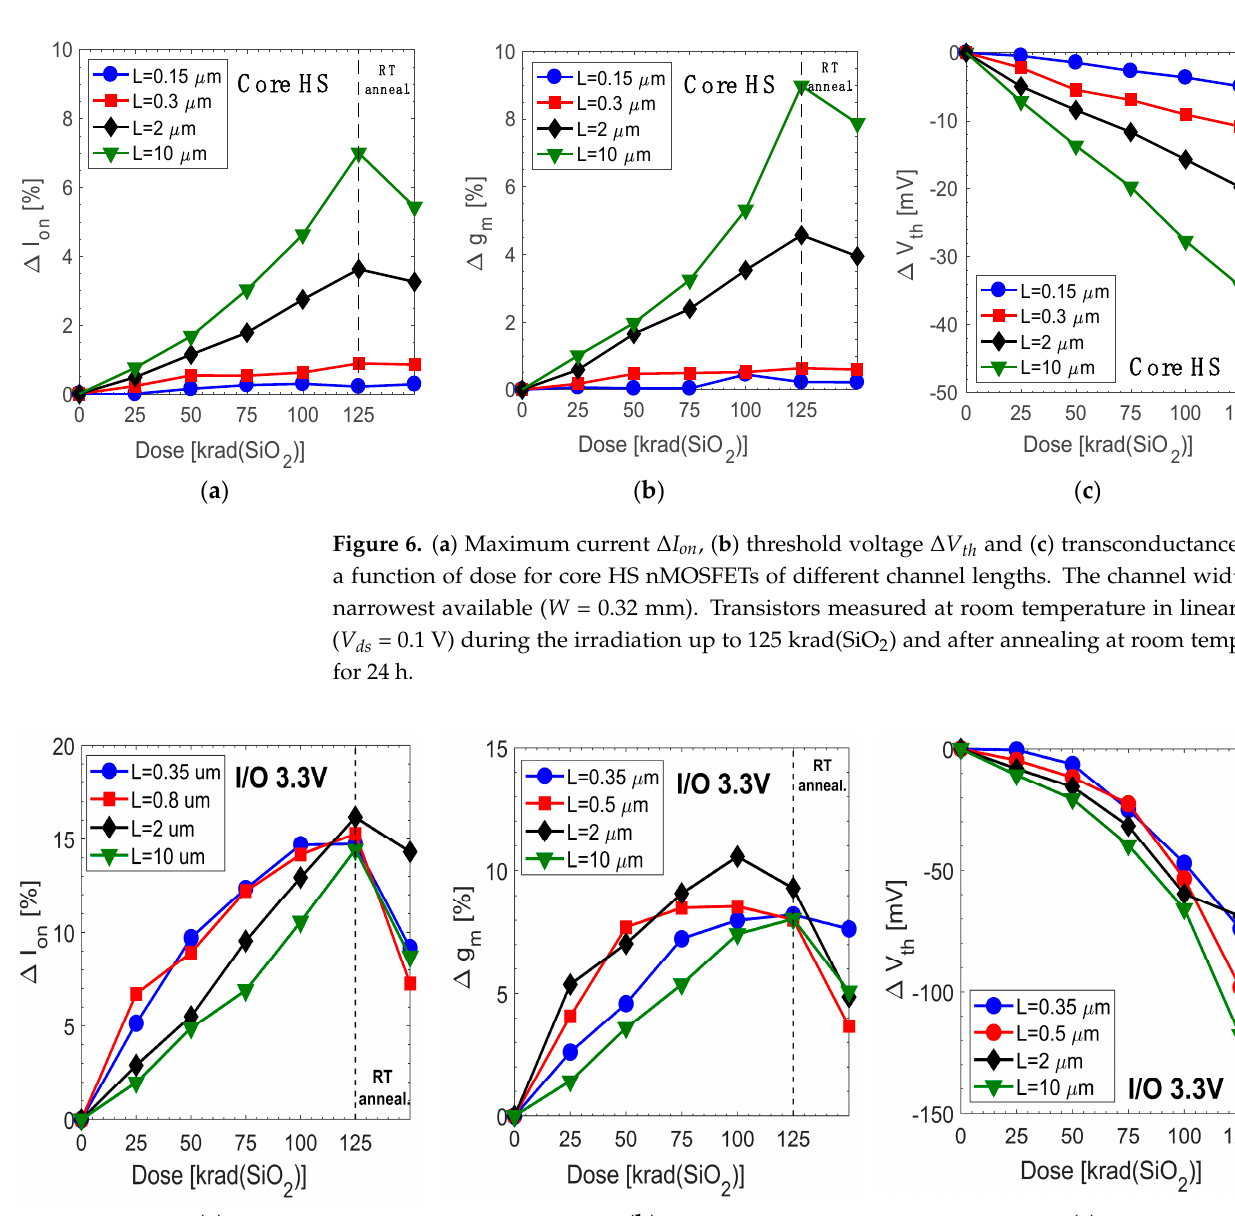
9 of 14 Figure 5. Δ V th is plotted as a function of the dose for devices with different channel widths, and the channel length is constant at 10 μ m. Transistors irradiated up to 125 krad(SiO 2 ), annealed at room temperature for 24 h and then annealed at 100 °C for 24 h (only I/O devices). All measurements are carried out at room temperature in linear regime ( V ds = 0.1 V). ( a ) I/O 5V devices and ( b ) core HS devices. 3.4. Channel-Length-Dependent Effects Figure 6 shows the dc parametric shifts of several core HS nMOSFETs with different channel lengths. All devices have the same channel width of 0.32 μ m, i.e., the narrowest width. The Δ I on curves evidence a general increase in the I on current, with the highest shift for transistors having the longest channel L = 10 μ m (green line) of about 7% of Δ I on after